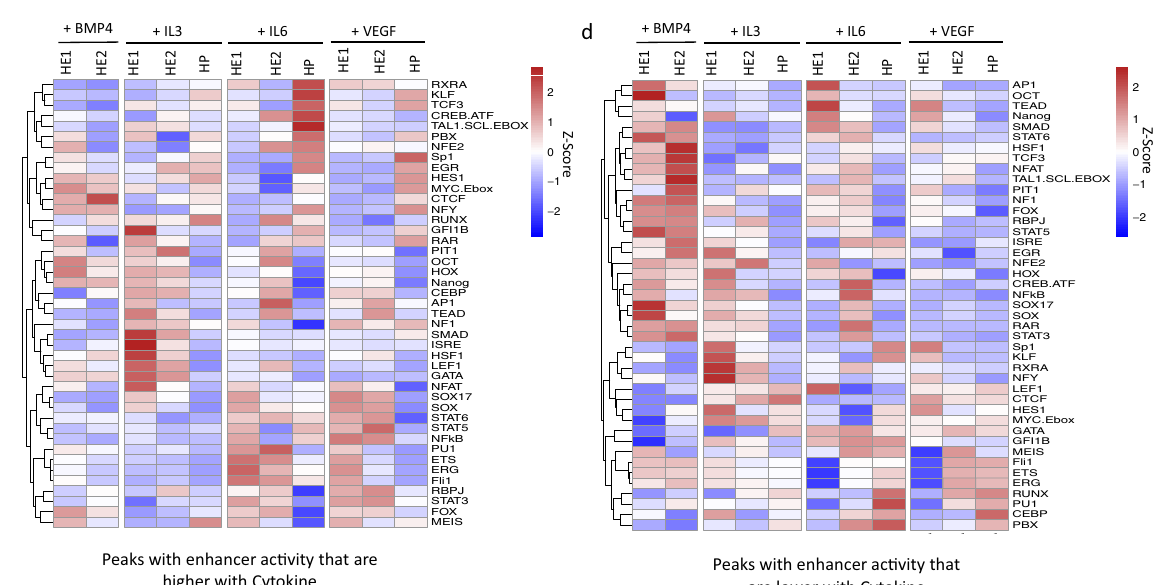
Fig. 4 | Identi fi cation ofcytokine-responsive enhancerelements.a Overviewof serum-free in vitro blood progenitor differentiation modi fi ed from 42 . Speci fi c cytokines that were left out at the beginning of blast culture are highlighted in green. b – d Identi fi cation of cytokineresponsivedistalelementsscoring positive in ourassayinthepresenceorabsenceoftheindicatedcytokines. b Overviewofmotif